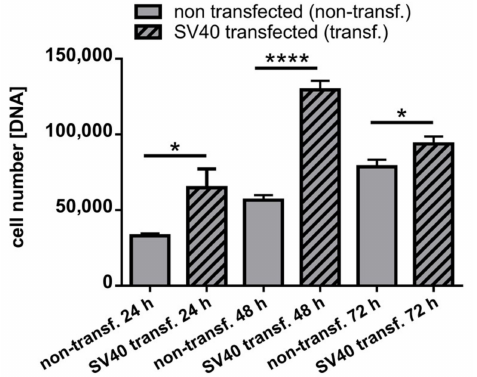
Figure 5. DNA content of 2D cultured non-transfected and SV40 transfected ACL ligamentocytes. Non-transfectedandtransfectedcellswereculturedfor24, 48, and72handDNAcontentwasdetermined by CyQuant assay. Calf thymus DNA served as a standard. Three independent experiments were performed. Transf.: transfected, * p < 0.05, **** p <